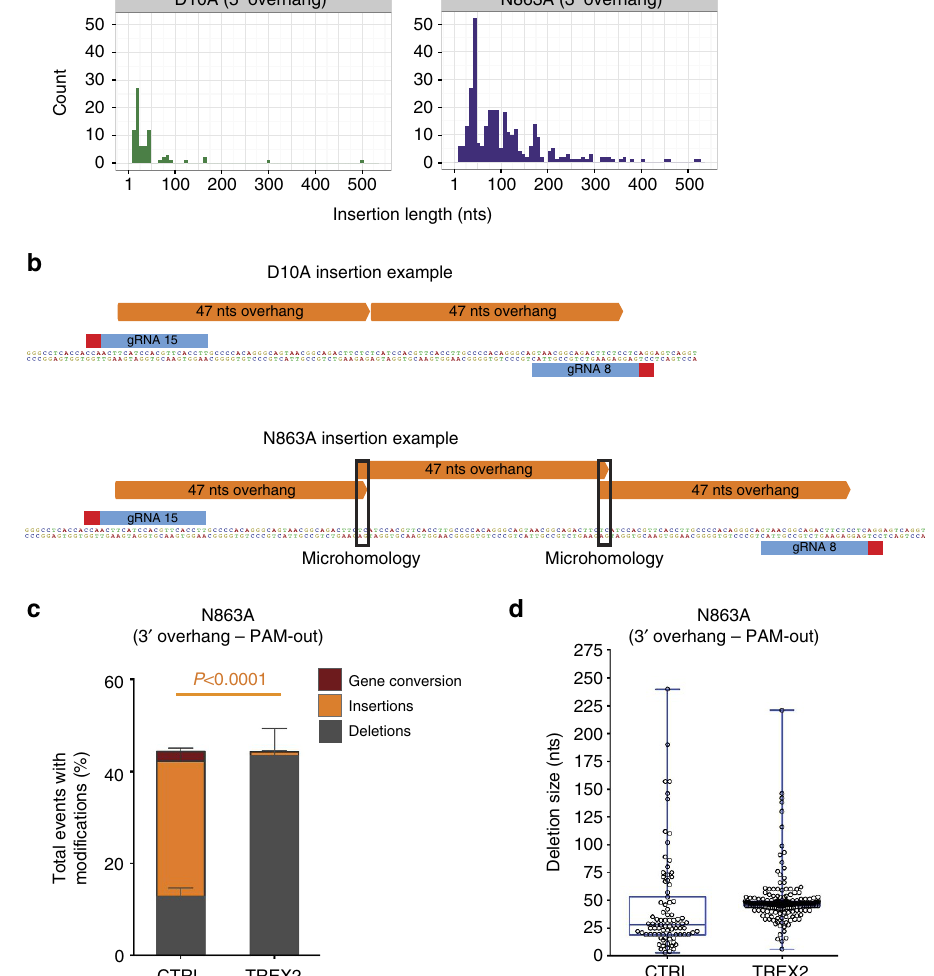
Figure 3 | Characterization of insertions deriving from the D10A and N863A Cas9 variants using gRNA pair 8/15 in PAM-out orientation. ( a ) Histogram plot of insertion length for the D10A Cas9 (green) and N863A Cas9 (purple)-induced insertions. Individual insertion size data from each Cas9 variant was scored from Sanger sequencing data of U2OS cells treated with either D10A or N863A Cas9 and gRNA pair 8/15. Difference in length between D10A and N863A-induced insertions is significant: P ¼ 1.274 (cid:2) 10 (cid:3) 12 (permutation test). Number of insertions plotted is 75 for D10A and 325 for N863A. ( b ) Example of insertions of the full overhang resulting from N863A and D10A Cas9-induced lesions. Insertions (indicated as filled orange arrows) induced from D10A Cas9 do not show overlap while those from N863A Cas9 do indicating microhomology usage in the latter case (indicated in black box). Position of gRNA indicated in blue, with red box representing the PAM. ( c ) Overall modification frequency resolved for deletions, insertions and gene conversion scored by Sanger sequencing of the amplified HBB locus in U2OS cells expressing the N863A Cas9 variant and gRNA pair 8/15 in the presence (TREX2) or absence (CTRL) of TREX2. The P value for the difference in insertion frequency was calculated using the two-tailed Student’s t -test. Data are represented as mean ± s.e.m. The total number of sequences plotted from six independent experiments is 684 for CTRL and 672 for TREX2-expressing cells. ( d ) Scatter dot plot overlaid with a box and whisker plot representing the deletions size scored from Sanger sequencing data of U2SOS cells expressing the N863A Cas9 variant with gRNA pair 8/15 in the presence (TREX2) or absence (CTRL) of TREX2. Each individual dot represents one Sanger sequenced read harbouring a deletion. The total number of sequences plotted from six independent experiments is 87 for control and 264 for TREX2-expressing cells. The line within the box depicts the median, with the box extending from the 25th to the 75th percentiles. The whiskers depict the minimum and maximum values of the data